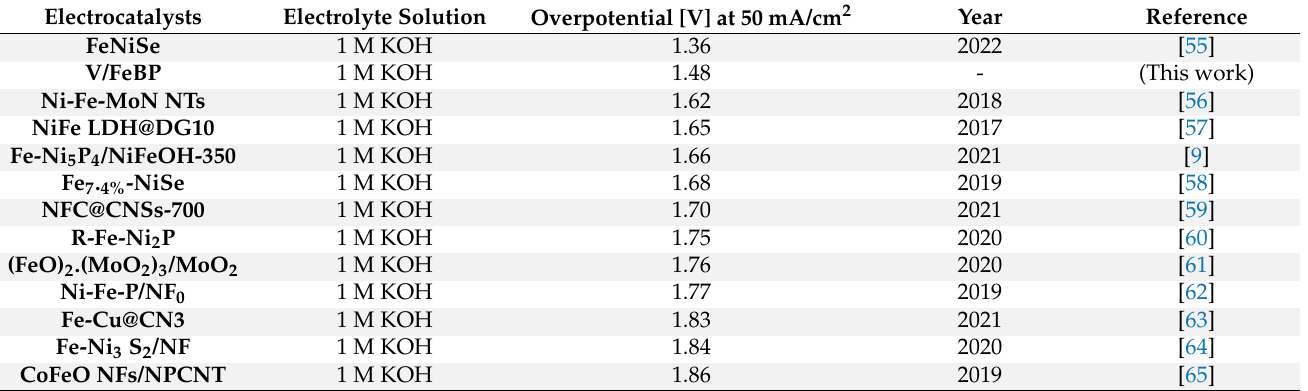
Table 1. Comparison of 2-electrode performance with the state-of-art Fe-based electrodes at density of 50 mA/cm 2 in 1 M